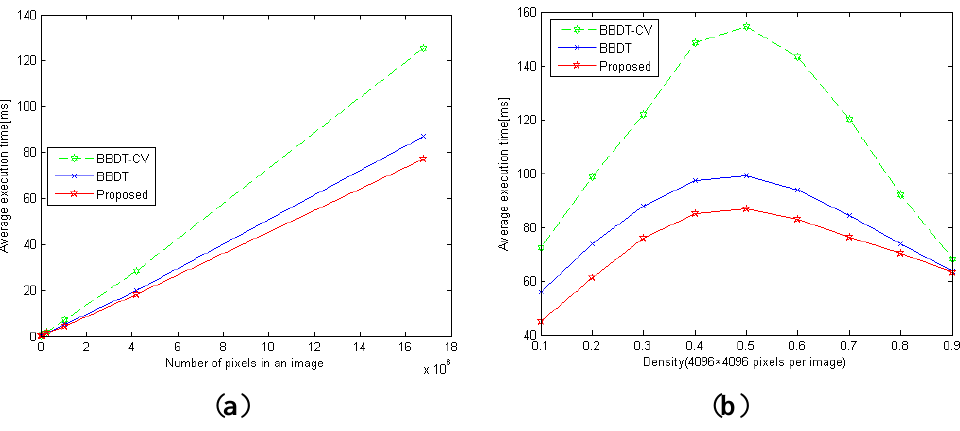
Figure 8. Execution time (ms) versus ( a ) the number of pixels in an image, and ( b ) the density of 4096 × 4096 pixel